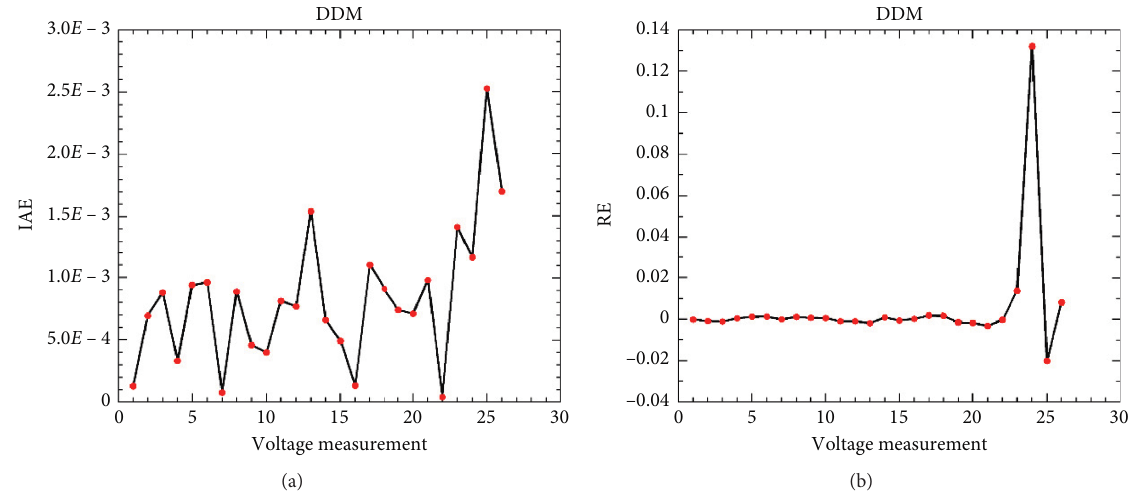
Figure 8: IAE (a) and RE (b) between the simulated data by DDM and the experimental Table 5: Simulated data and associated IAE obtained by MWAO on SDM.